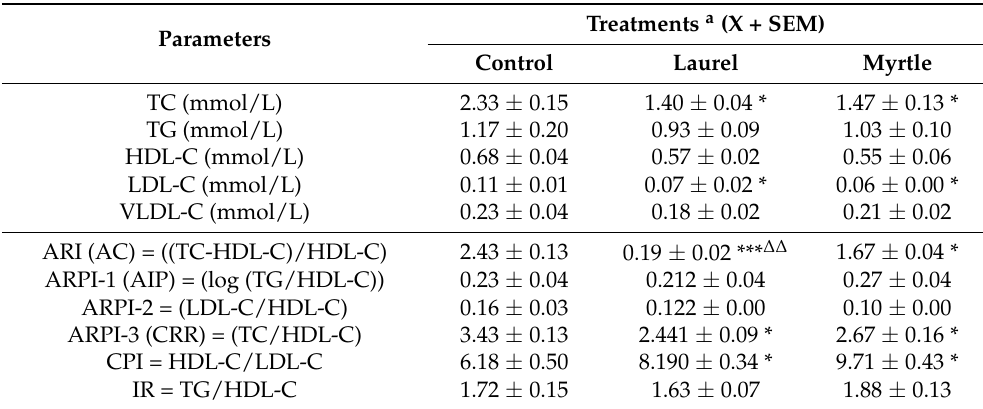
Table 5. Effect of laurel and myrtle EO application on the serum lipid biochemical parameters, atherogenicity and atherogenic risk predictor indices in